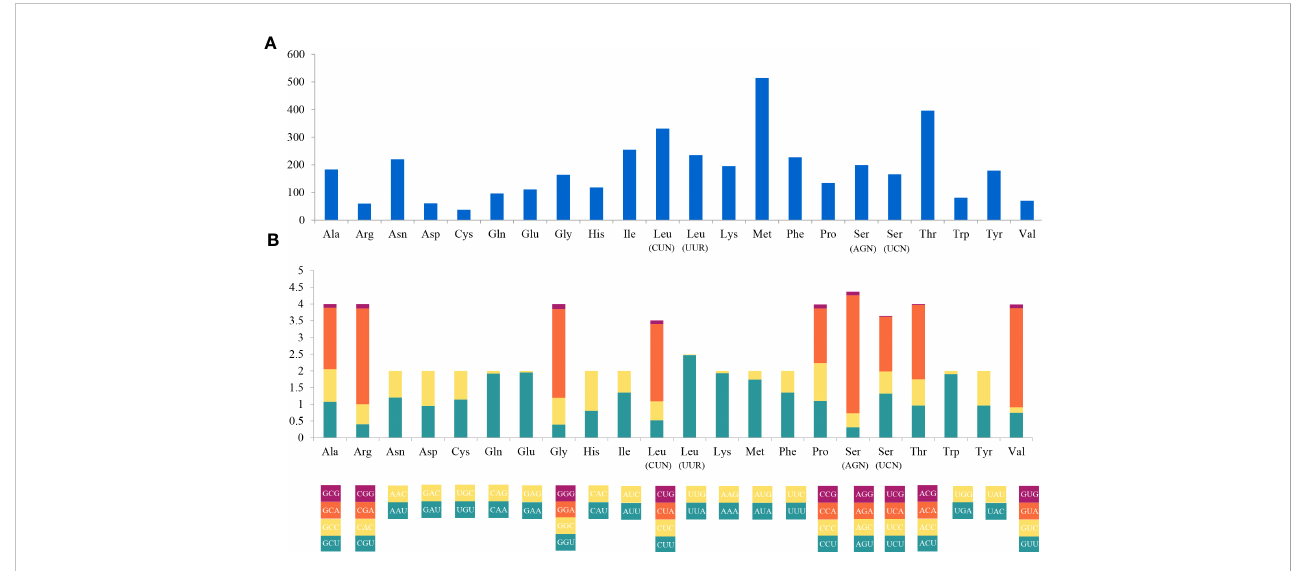
FIGURE 5 Codon usage (A) and the relative synonymous codon usage (RSCU) (B) of the Caulophacus ( Caulodiscus ) iocasicus sp. nov. mitogenome. Numbers to the left refer to the total number of codons (A) and the RSCU values (B)